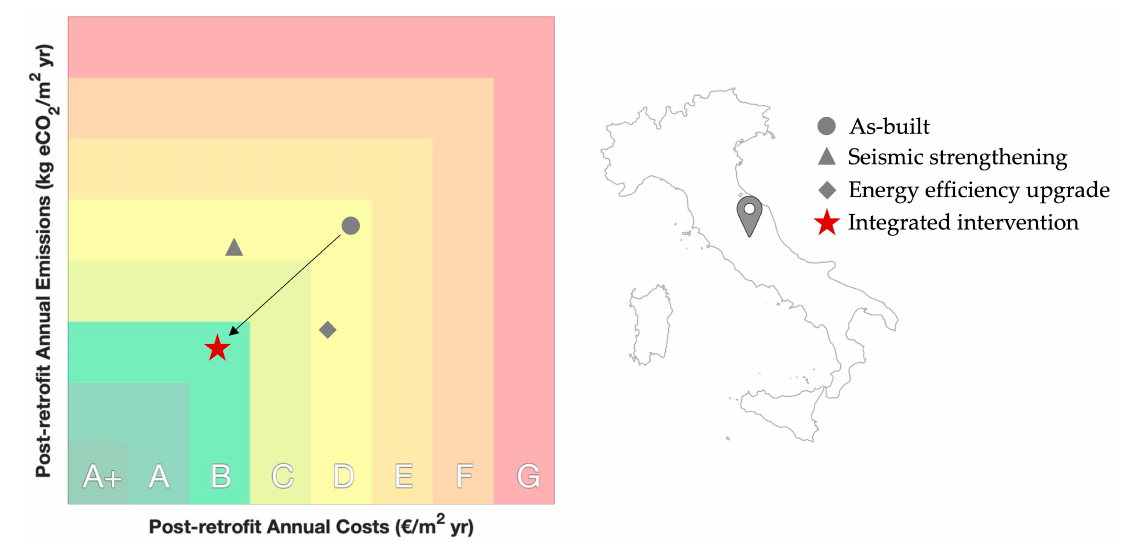
Figure 8. Potential seismic vulnerability—energy efficiency classification scheme for